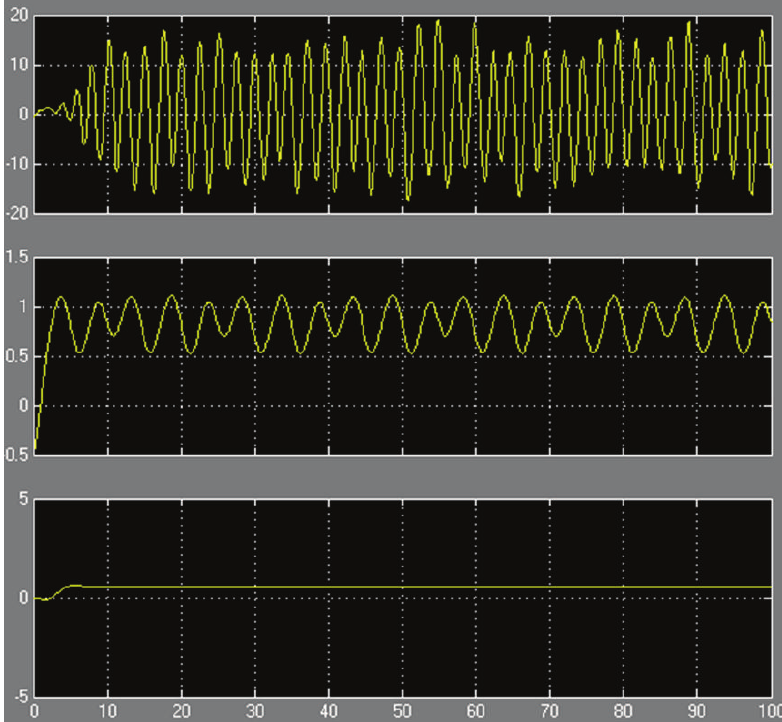
Figure 13: MPC controller (bottom graph) is shown against the nonlinear proportional-only controller (topmost) and optimized proportional-only controller (middle); the magnitude of controller response is shown over 100sec interval.